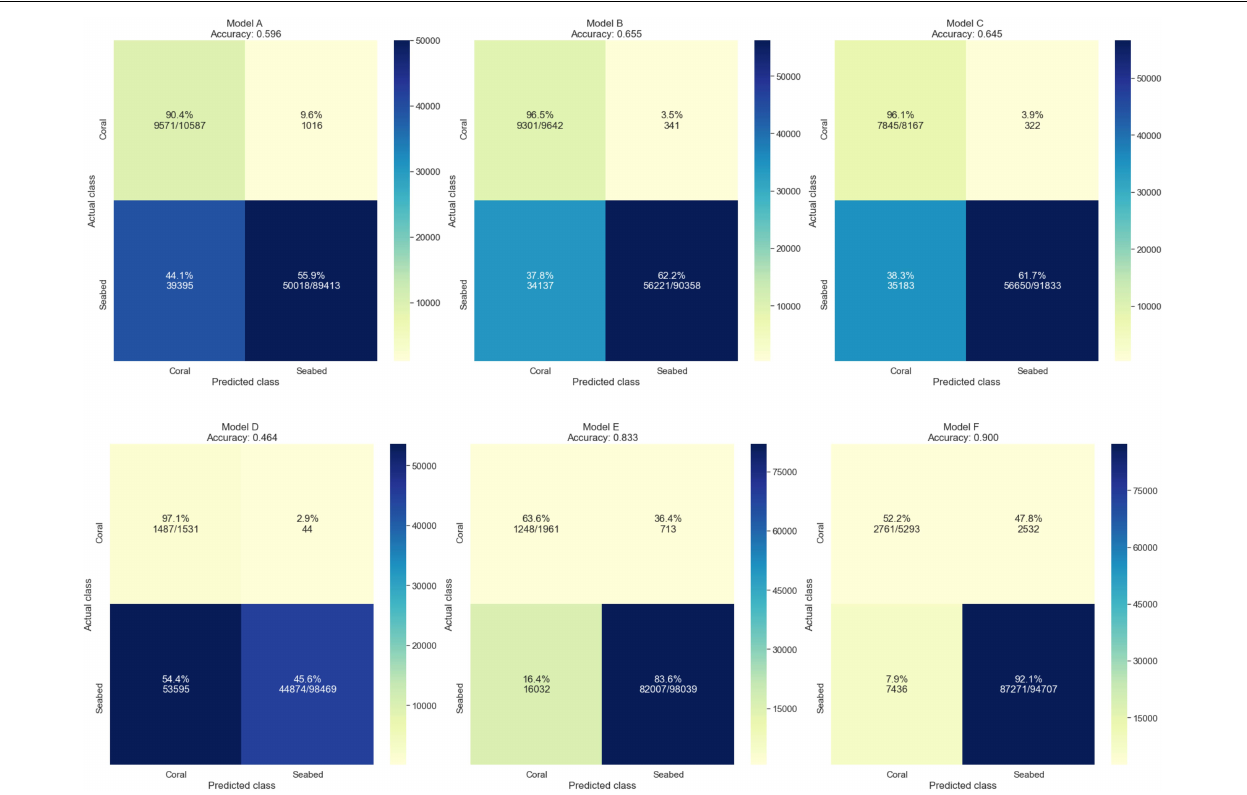
FIGURE 5 | Confusion matrices representing the MGC classification results for each dense cloud reconstruction. Confusion matrices show the accuracy score and the relationship between the referenced data and the classification. The “Actual class” on the y -axis refers to the manually annotated data, whereas the “Predicted class” on the x -axis relates to the classification output. The main diagonal of the matrices lists the correctly classified percentage of points per class. The colour scale bar on the right of each confusion matrix represents the number of points.